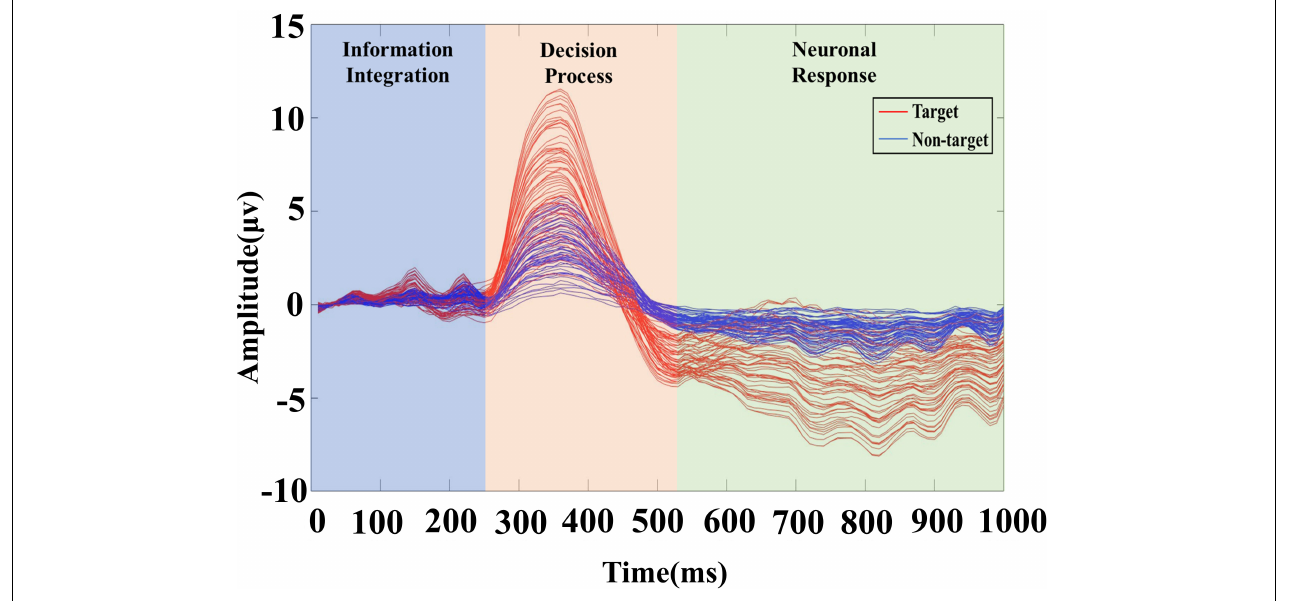
FIGURE 3 | The brain response of the video target. After overlaying and averaging the EEG signals of all trials according to the channel, the red curve represents the target trial data, and the blue curve represents the non-target trial data.